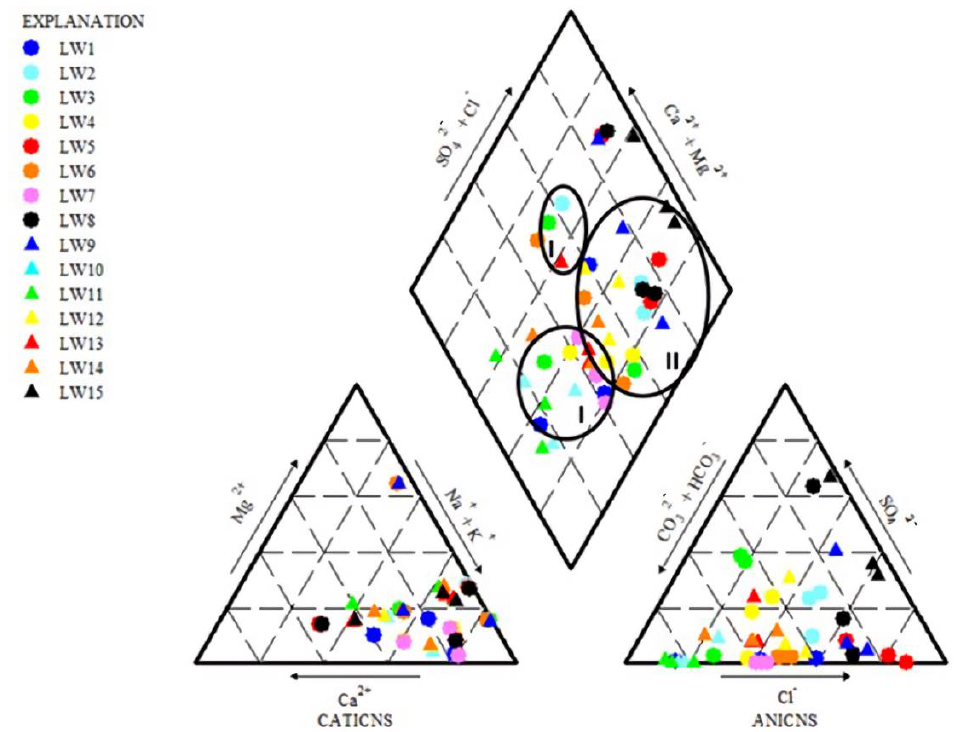
Figure 2. Piper trilinear diagram showing hydrogeochemical facies. Na-HCO 3 water type (Circle I) and Na-Cl water type (circle II).